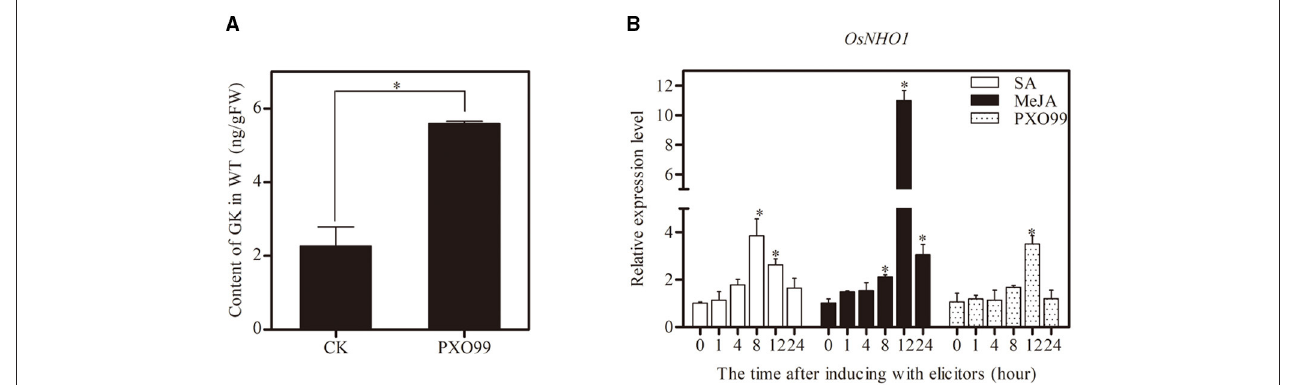
FIGURE 2 | Determination of GK content and expression profiles of OsNHO1 treated with Xoo -PXO99. (A) The GK level was increased by Xoo infection in rice leaves after inoculation with the Xoo -PXO99. (B) Transcriptional levels of OsNHO1 in plants treated with JA, SA, and Xoo -PXO99. Each value represents the mean ± SE of three biological replicates. GK, glycerol kinase; JA, jasmonic acid; SA, salicylic acid. * indicates a significant difference at the 0.05 level.